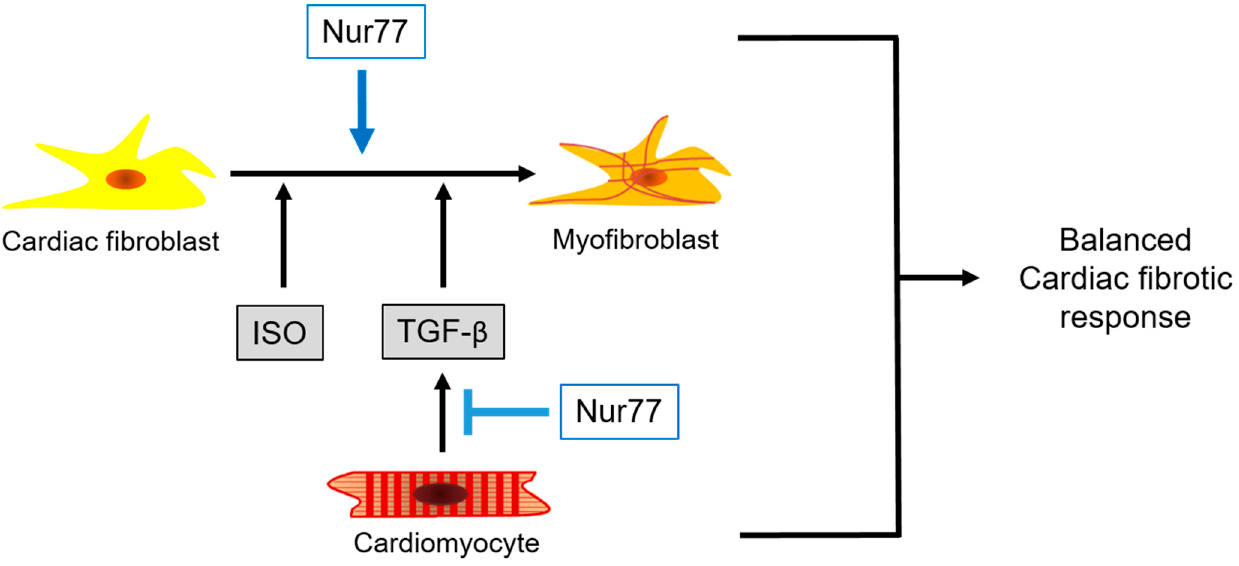
Figure 7. Proposed working model. Nur77 in cardiac fibroblasts promotes ISO and TGF- β -induced fibroblast-to-myofibroblast transition, while Nur77 in cardiomyocytes represses the ability of these cells to induce paracrine TGF- β -mediated fibroblast-to-myofibroblast transition, thereby balancing the cardiac fibrotic response. ISO: isoproterenol, TGF- β : transforming growth factor- β